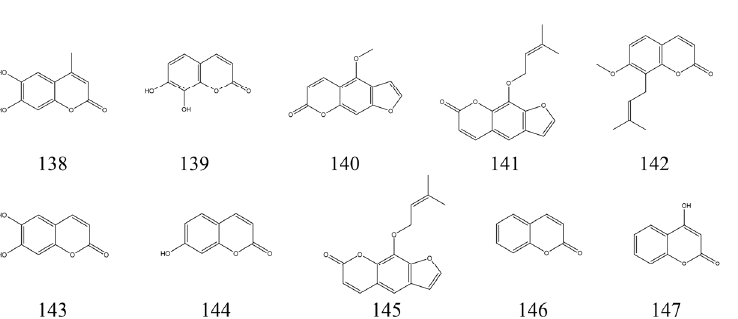
Figure 10. Structural formulae of coumarin analogues with IBD therapeutic effects. Table 7. In vivo therapeutic effects of coumarins on experimental IBD.